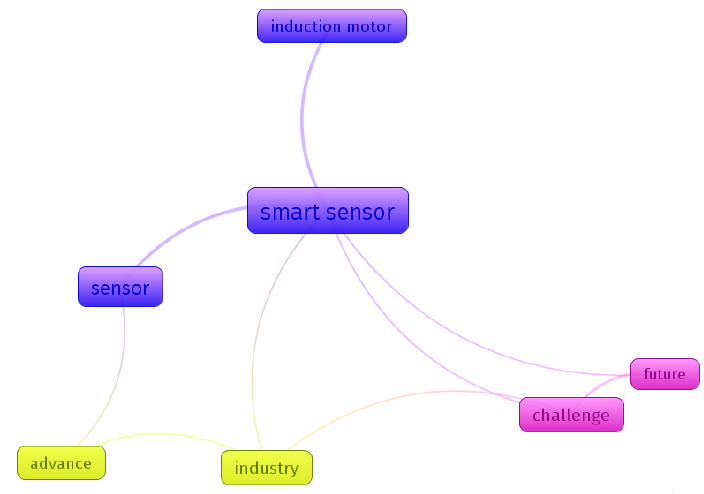
Figure 5. VOS viewer network connection.